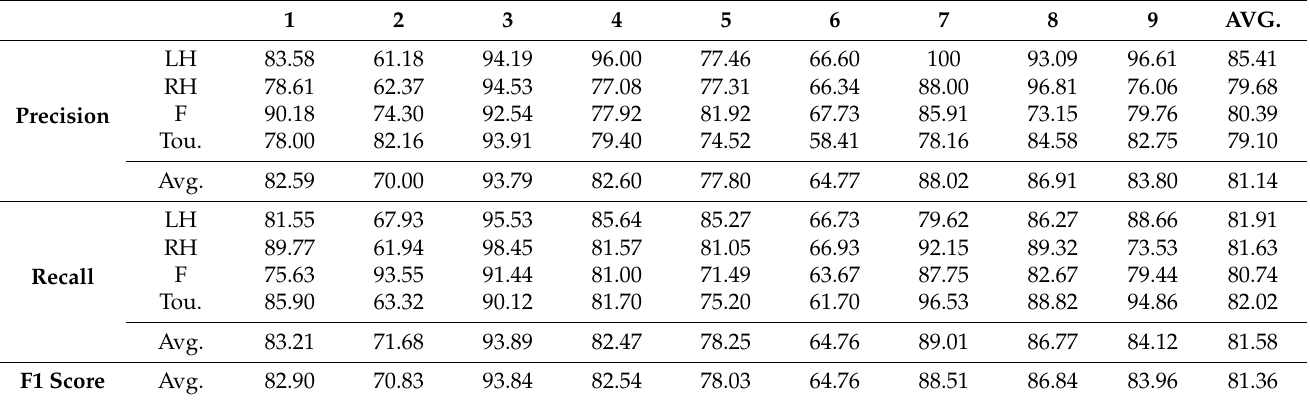
Table 5. Precision, recall, and F1 Score on the MI BCI IV-2a dataset using MBShallowConvNet.